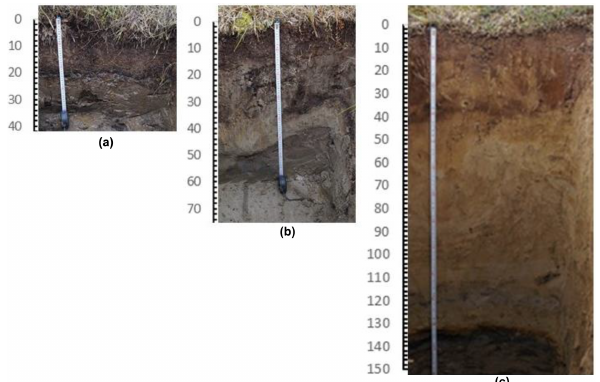
Figure 4. Soil profiles showing the depth of active layer 40–150cm near Bovanenkovo site. Tundra Histic Crysol with permafrost oc- curring at 40cm (a) consist of horizons O-Bg. The O horizon con- sists of organic horizon containing decomposed organic matter and peat. Bg is mineral gley horizon of soil, gray with bluish hue, light loam texture, sand. (b) Histic Crysol with permafrost occurring at 70cm consist of horizons O-B1-B2-Cg. Soil horizon O consist of peat. The mineral horizons B1 and B2 are heterogeneous in color, gray with dark spots and light loam texture. Cg mineral horizon con- sist of unconsolidated earth material with gray sandy loam texture. (c) Eutric Cryosols with permafrost occurring at 150cm depth. The soil consist of horizons A-Bg-Cg. Mineral horizon A dark brown, sandy loam texture with fine grained material sand. Bg mineral hori- zon, yellow brown to dark brown and sandy loam texture. Cg is light brown and sandy